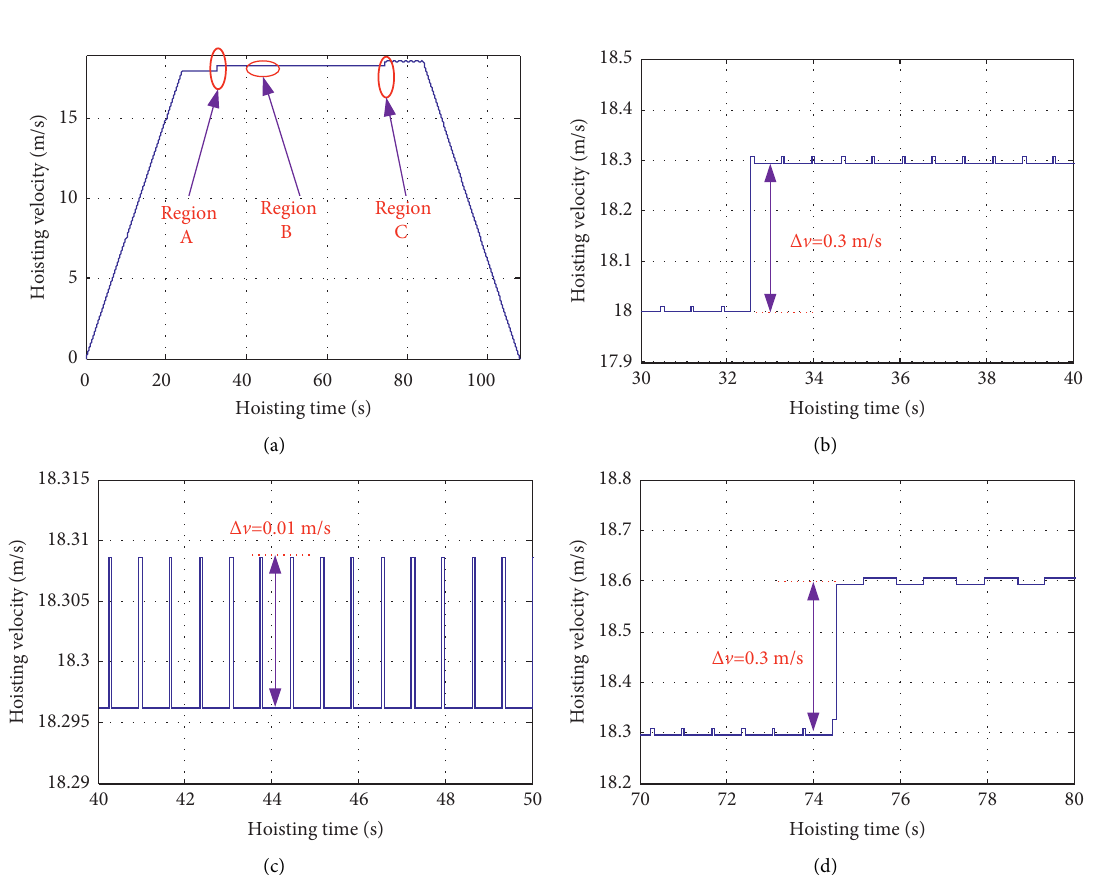
Figure 4: Hoisting velocity derived from rope winding. (a) Hoisting velocity during the whole winding process. (b) Enlarged view of region A. (c) Enlarged view of region B. (d) Enlarged view of region